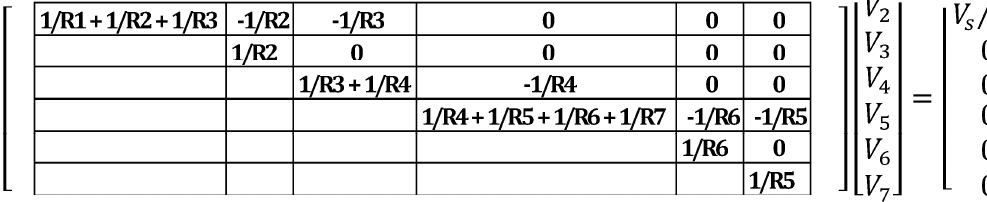
Figure 16. Top non-diagonal elements of the conductance matrix